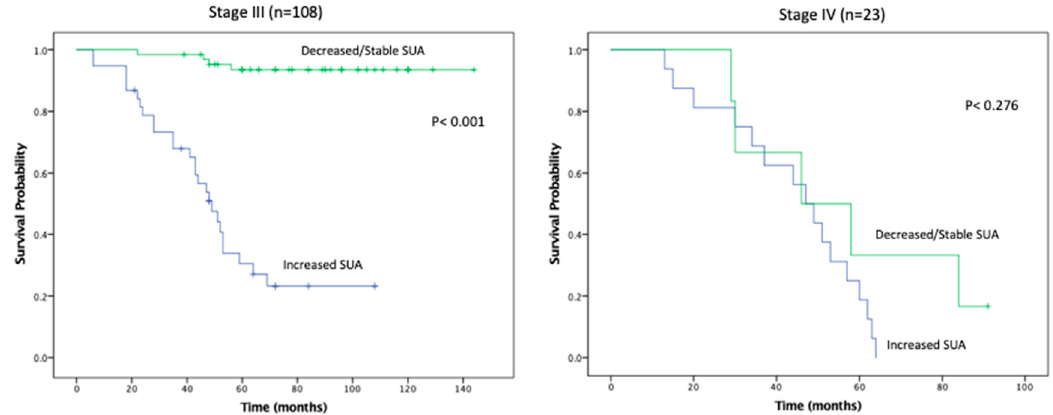
Figure 4. Kaplan-Meier plot for recurrence free survival in the stable / decreased uric acid and increased uric acid groups, separated by disease stage.